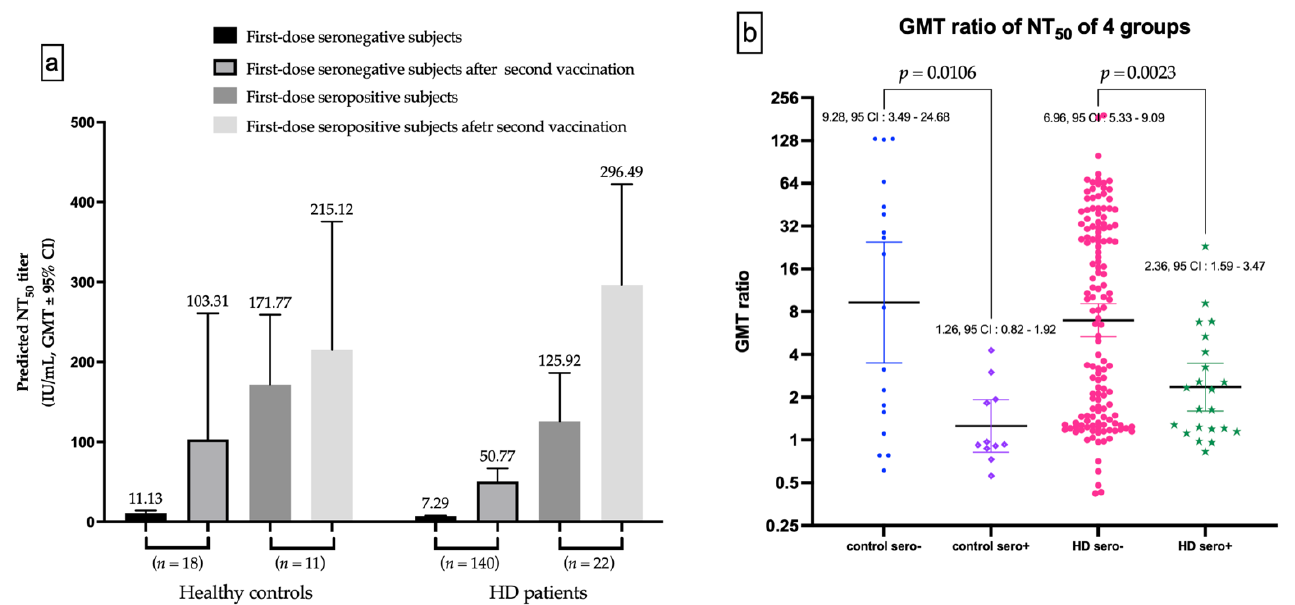
Figure 5. ( a ) The Difference of NT 50 evolutions in first-dose seronegative and first-dose seropositive subgroup. ( b ) The difference of gemetric mean titer (GMT) ratio between first-dose seronegative and first-dose seropositive controls, and between first-dose seronegative and first-dose seropositive hemodialysis (HD) patients.